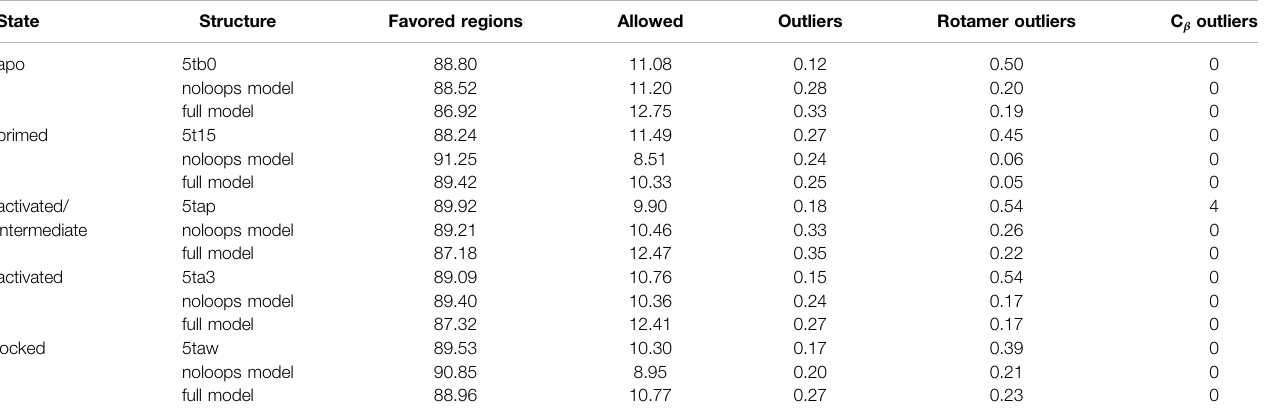
TABLE 3 | Molprobity validation results (% residues) for the models derived from the fi ve structural RyR1 templates used. State Structure Favored regions Allowed Outliers Rotamer outliers C β